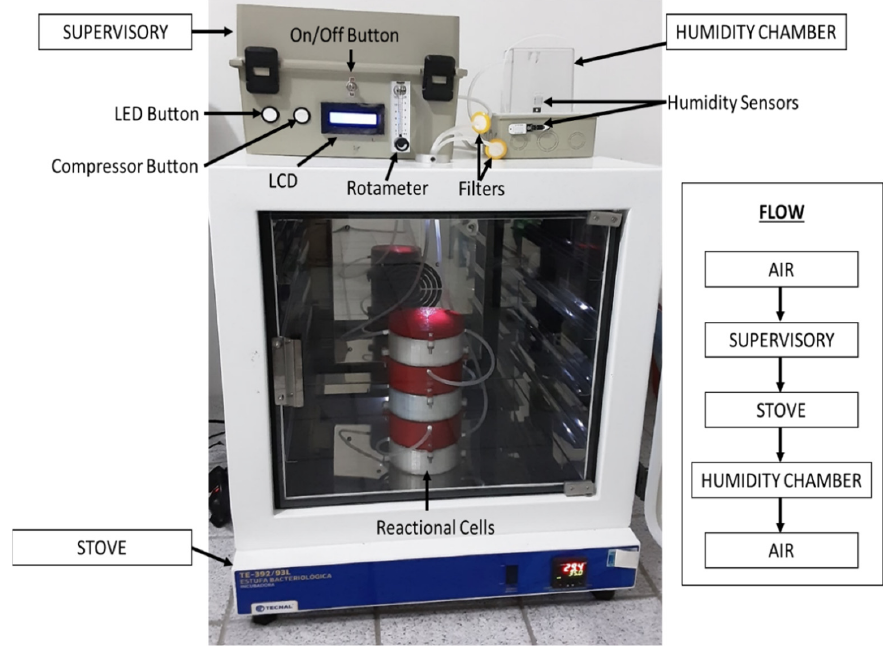
Figure 6. Overall Cascade System for Biomineralization in Cement.